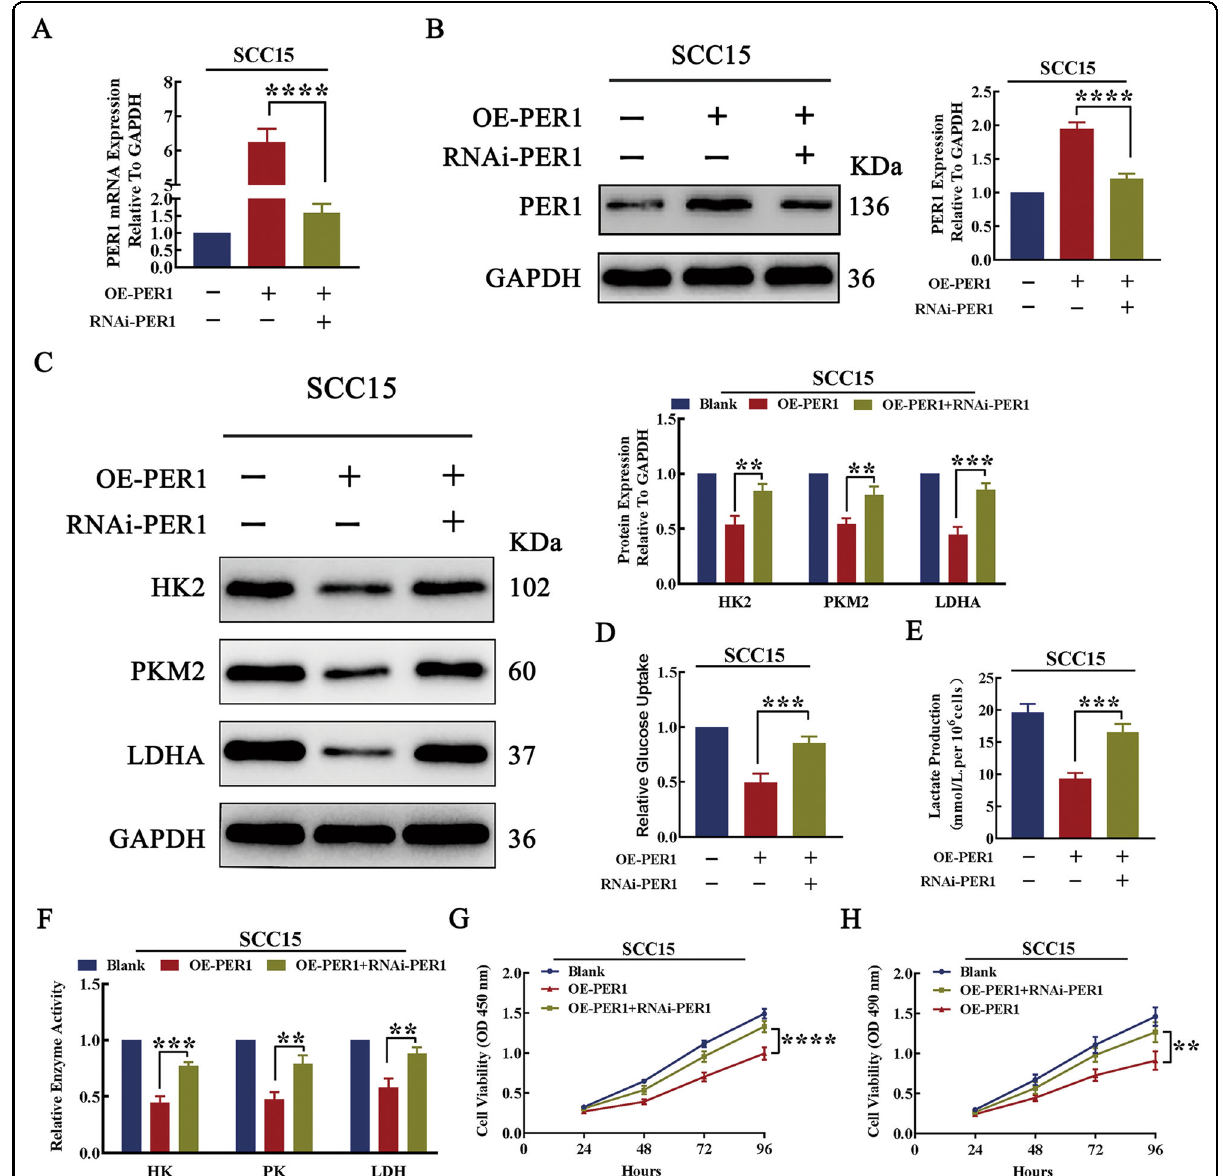
Fig. 3 PER1 regulated glycolysis and proliferation in OSCC cells. A , B The results of RT-qPCR and western blotting showed that the mRNA and protein expression levels of PER1 were signi fi cantly decreased after knockdown of PER1 in OE-PER1-SCC15 cells. C Western blot results showed that the decrease in the expression of HK2, PKM2, and LDHA was signi fi cantly reversed after knockdown of PER1 in OE-PER1-SCC15 cells. D – F The glucose uptake, lactate production, and enzyme activity assay results showed that the decreases in glucose uptake, lactate production, and enzymatic activity of HK, PK, and LDH were signi fi cantly reversed after knockdown of PER1 in OE-PER1-SCC15 cells. G , H The CCK-8 assay and MTT assay showed that the decrease in proliferation was signi fi cantly reversed after knockdown of PER1 in OE-PER1-SCC15 cells. All data are from three independent experiments. The data are presented as the mean ± SD values ( n ≥ 3). * P < 0.05; ** P < 0.01; *** P < 0.001; **** P <